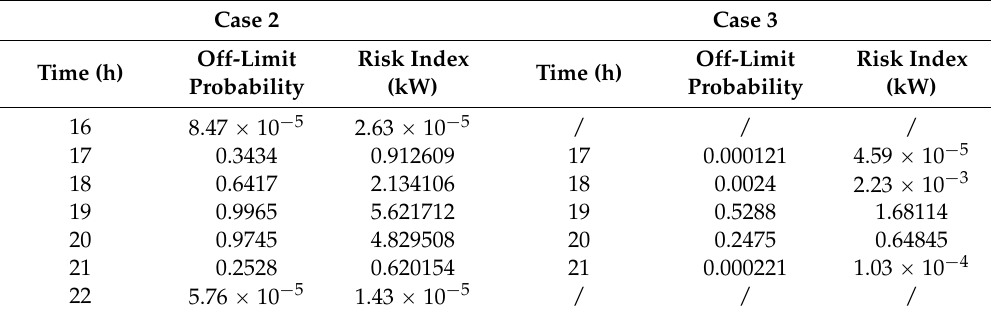
Table 2. The risk assessment results of the bus